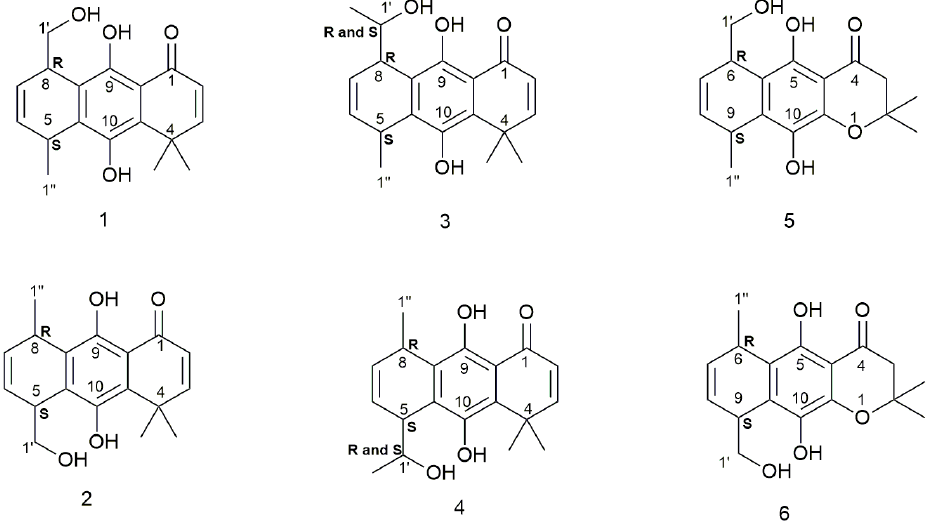
Figure 1. Structure of molecules studied in this work.